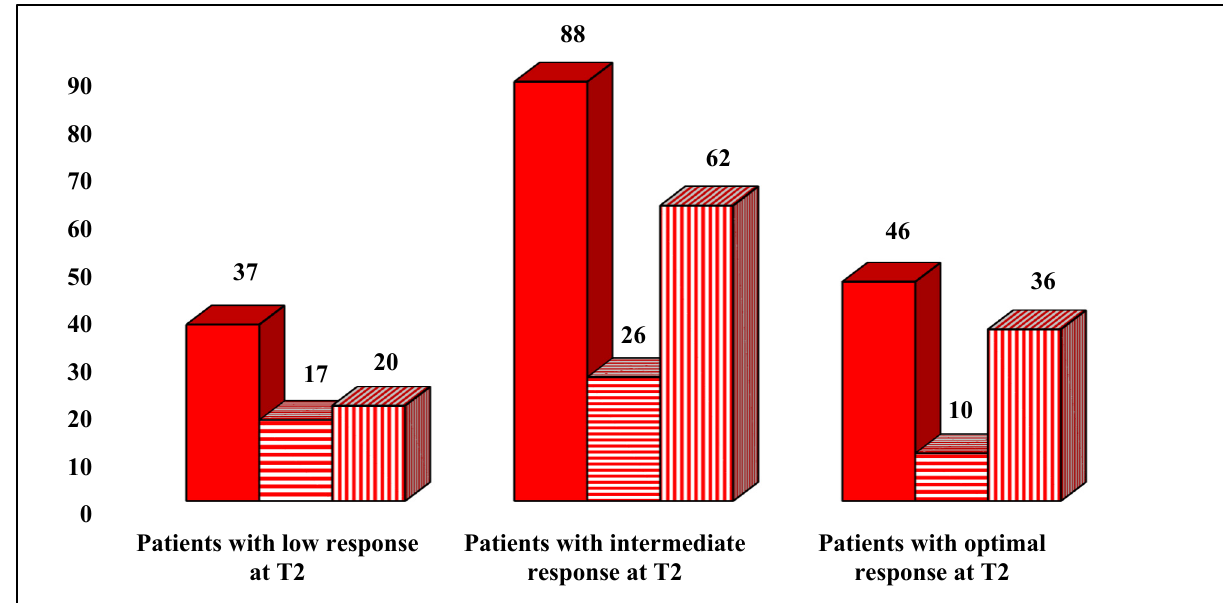
The frequency of patients with PUD, LLV and OV was comparable in patient cohorts